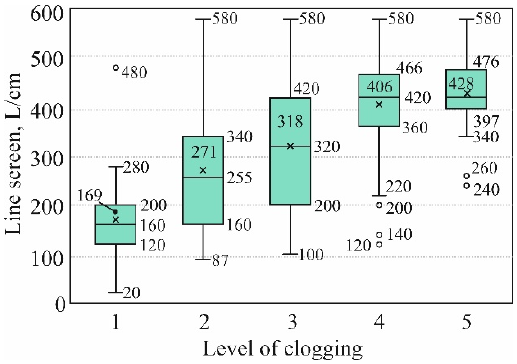
Figure 10. Line screen distribution of anilox rollers according to the level of clogging.